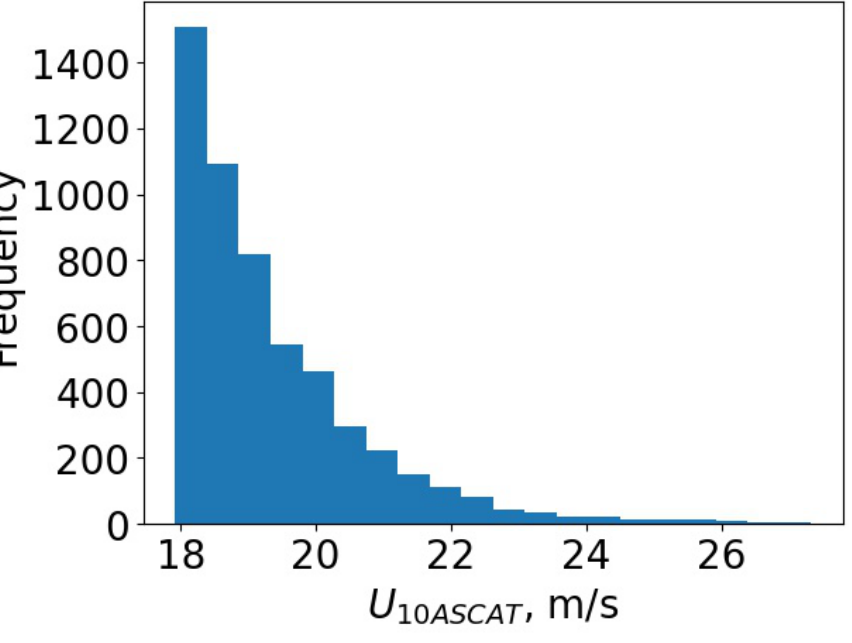
Figure 3. Histogram of the Advanced Scatterometer (ASCAT) wind speed above 18 m/s in the collocated